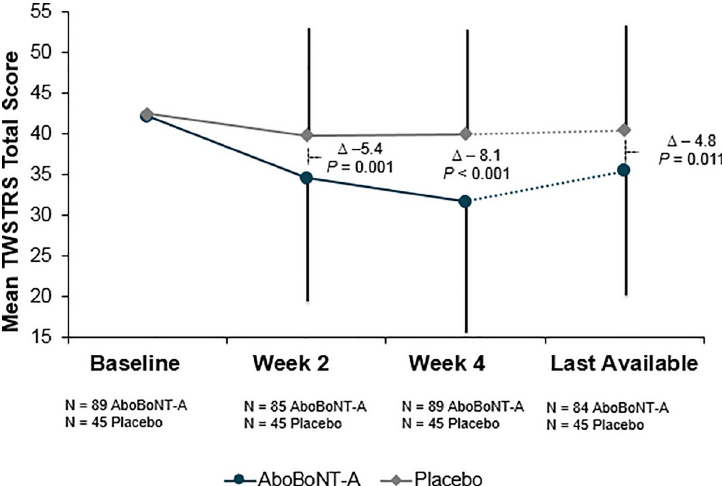
Fig 2. Mean TWSTRS total score. aboBoNT-A = abobotulinumtoxinA; ITT = intent-to-treat (all randomized patients); last available � = last available post-baseline (end of study or early withdrawal); TWSTRS = Toronto Western Spasmodic Torticollis Rating Scale; Δ = weighted overall treatment difference. Error lines indicate standard deviation. � Last available = last available post-baseline (end of study or early withdrawal), mean (SD) study drug exposure: 62.6 (37.8)